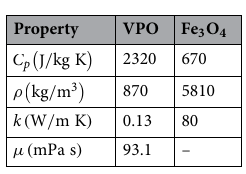
Table 1. Thermophysical properties of VPO and Fe 3 O 4 nanoparticles 41